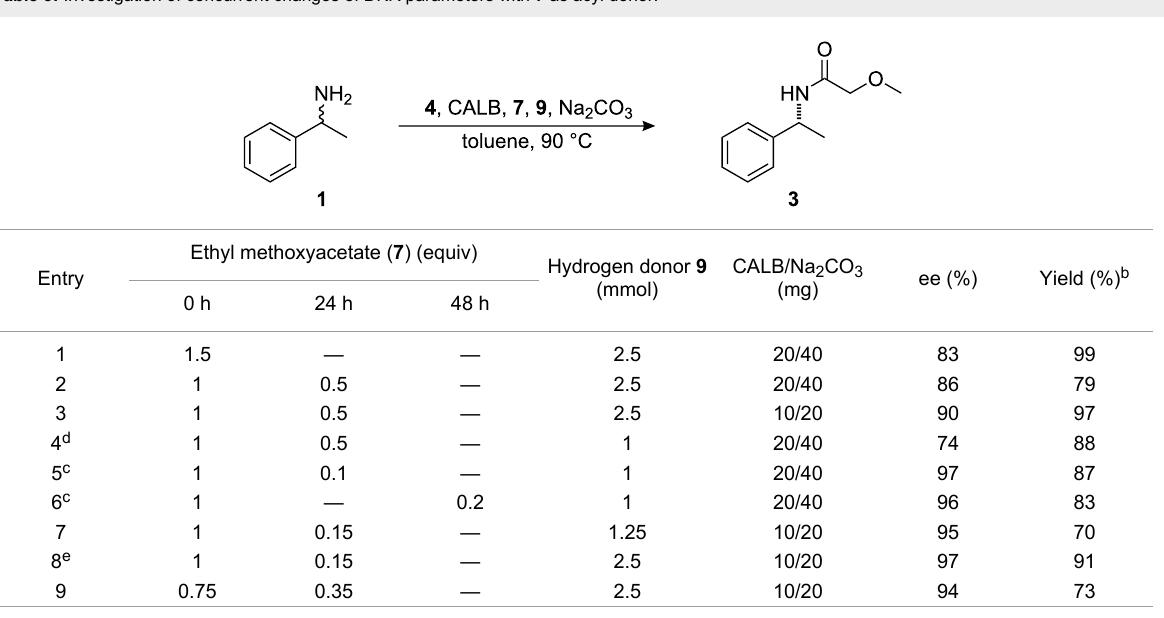
Table 3: Investigation of concurrent changes of DKR parameters with 7 as acyl donor.